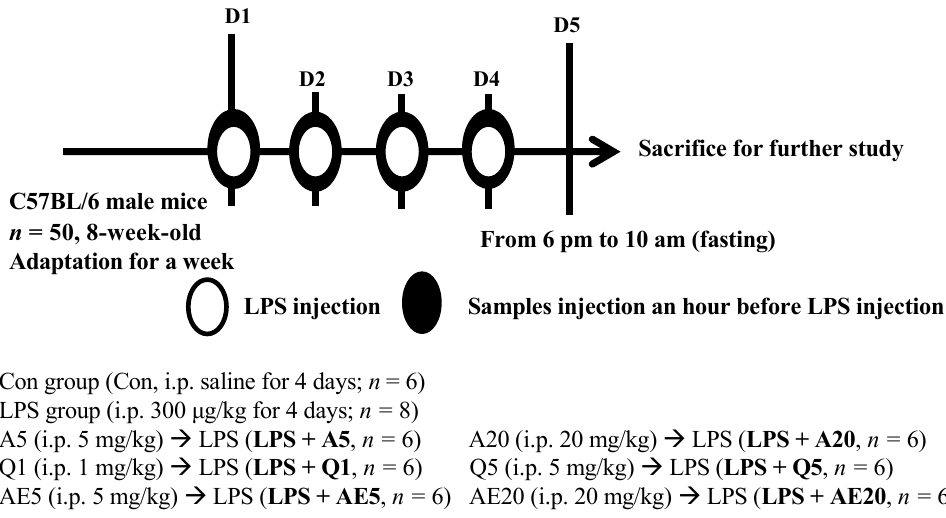
Figure 2. Experiments were carried out according to the schematic illustration. Abbreviations: astragalin (A), isoquercitrin (Q), and 70% ethanol extract of A. scaber (AE).